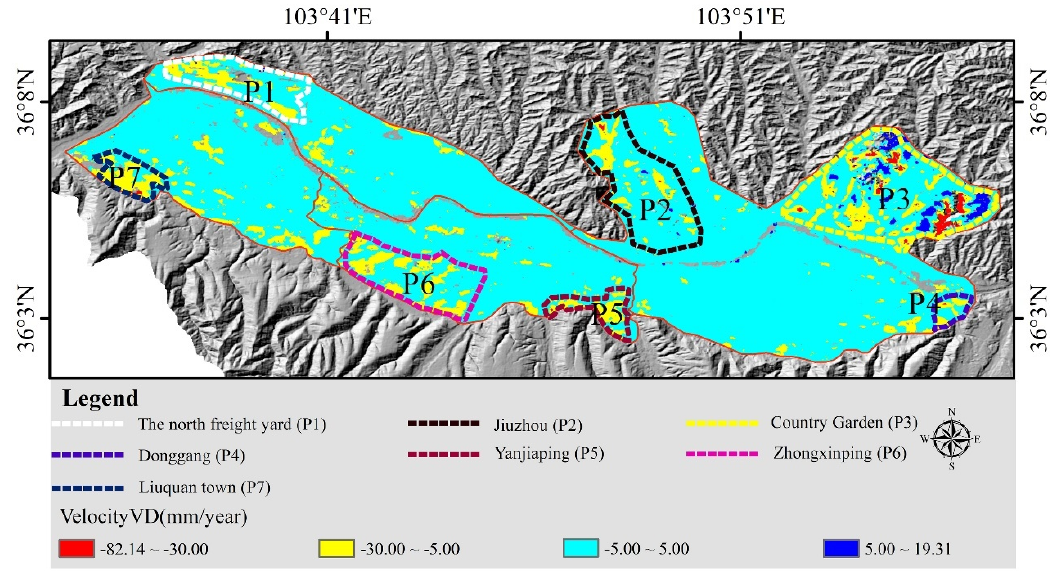
Figure 6. The mean surface deformation rate map of Lanzhou.